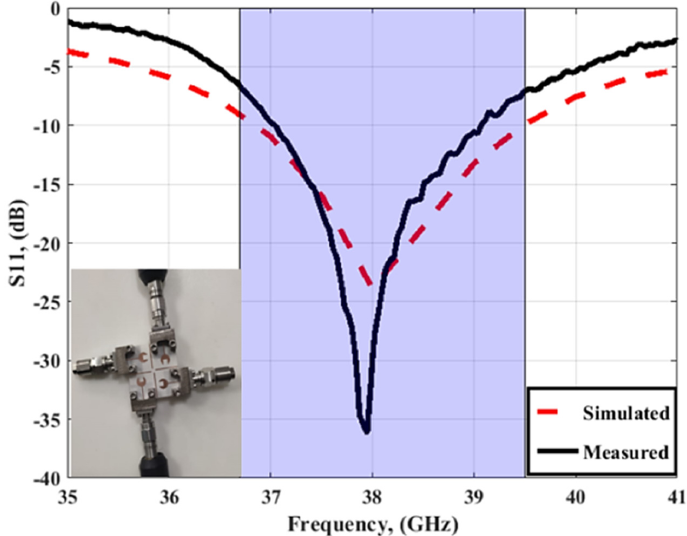
Figure 11. The fabricated prototype photo (Top/Back views) of the 4-port MIMO antenna.